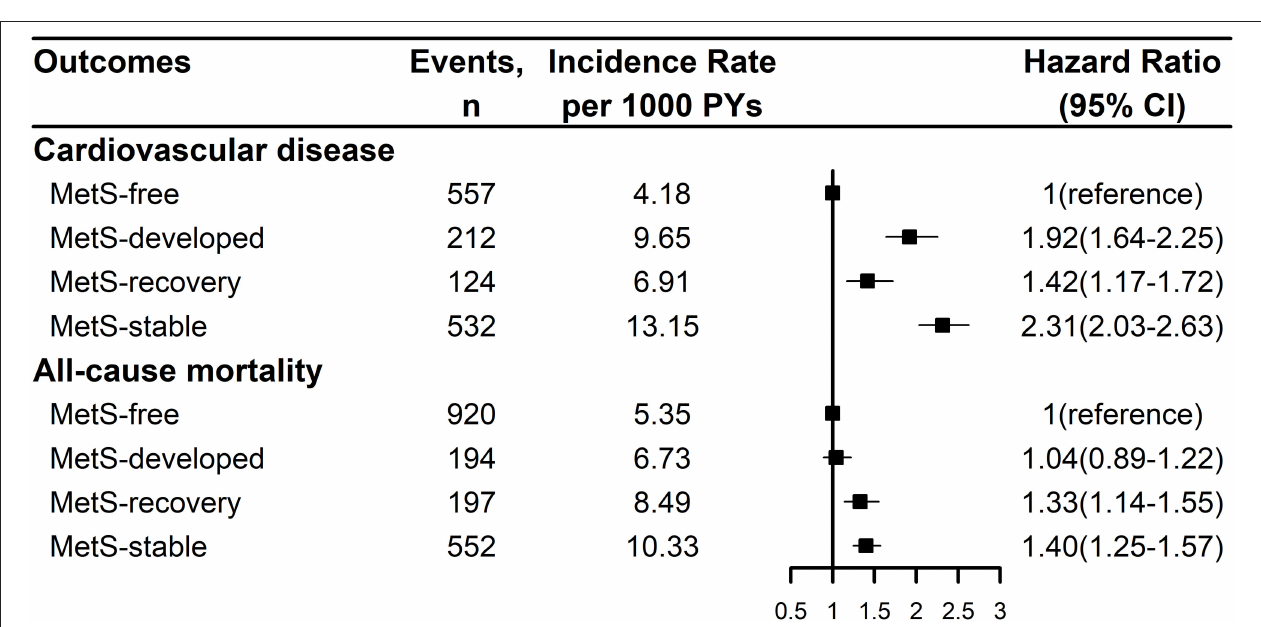
FIGURE 3 | Incidence rates and risks of cardiovascular disease and all-cause mortality by the dynamic patterns of MetS. Cardiovascular disease was the composite of myocardial infarction, stroke, and heart failure. Hazard ration was adjusted for age, sex, marital status, education level, smoking status, drinking status, physical activity level, salt intake, use of anti-hypertensive drug, anti-diabetic drug, lipid-lowering drug, and family history of myocardial infarction, stroke. MetS, metabolic syndrome; PY, person-year; CI, confidence interval.